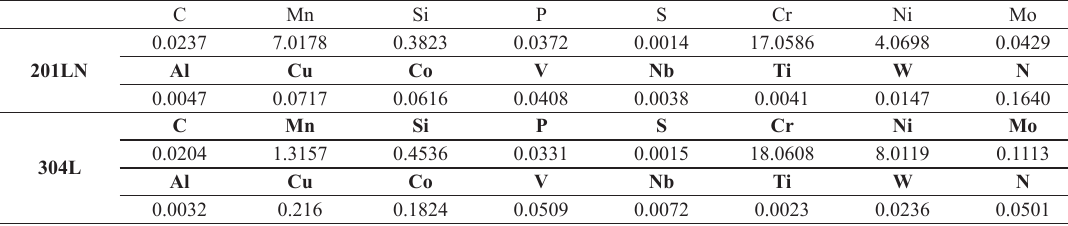
Table 1. Chemical composition (wt.%) of ASS 201LN and 304L (Fe in